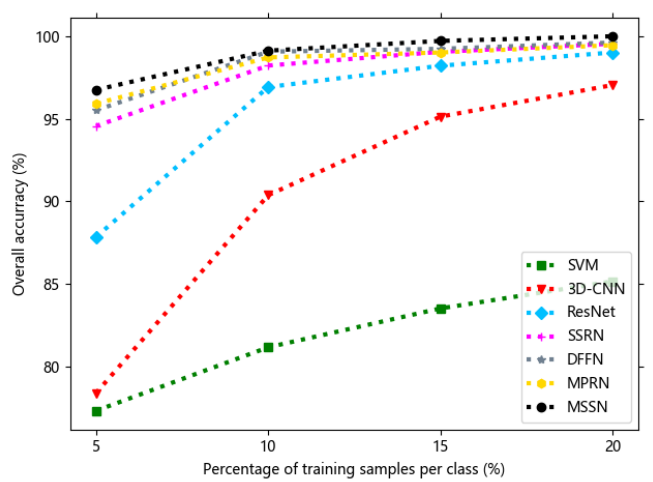
Figure 10. Overall classification accuracies obtained by di ff erent methods when considering di ff erent percentages of training samples on the Indian Pines data set.